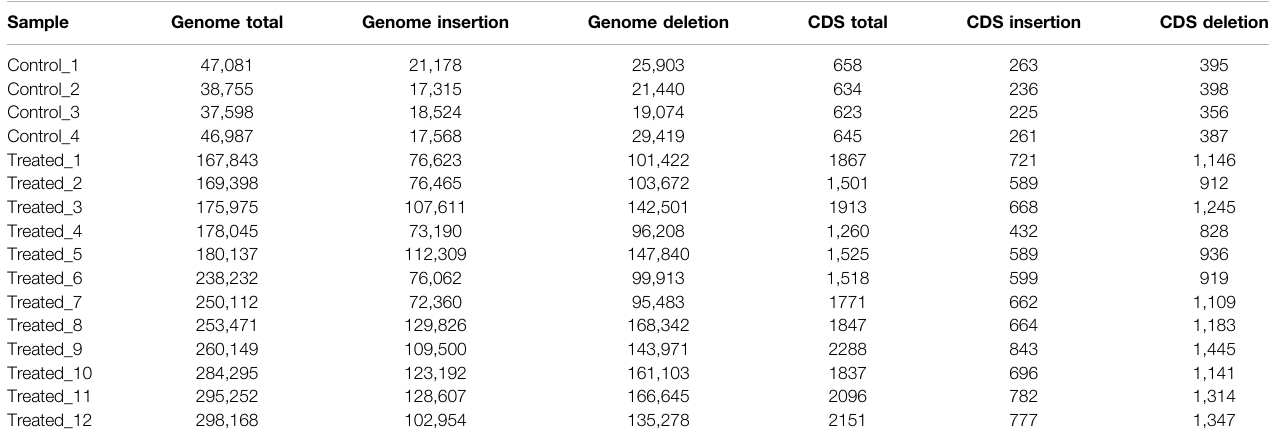
TABLE 8 | InDels in the control and EMS treated group after removing shared types with controls.